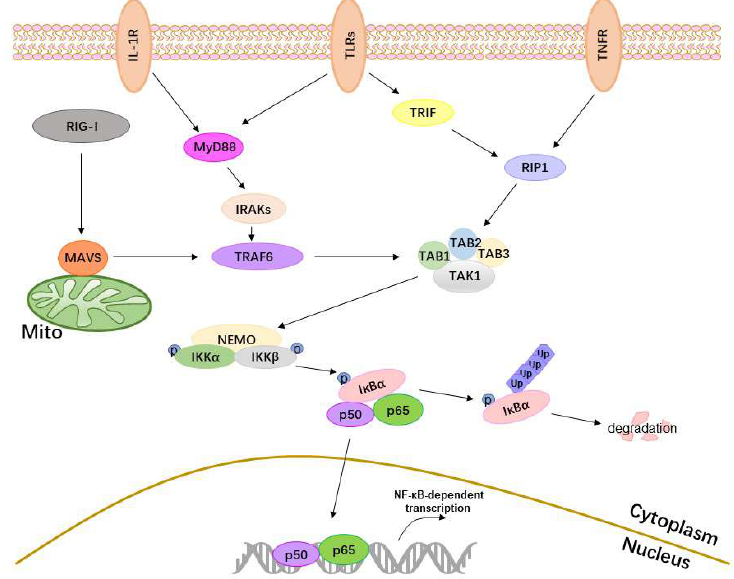
Figure 1. The activation of the NF-κB. The major upstream receptors of NF-κB—TLRs, RIG-I, TNFR,